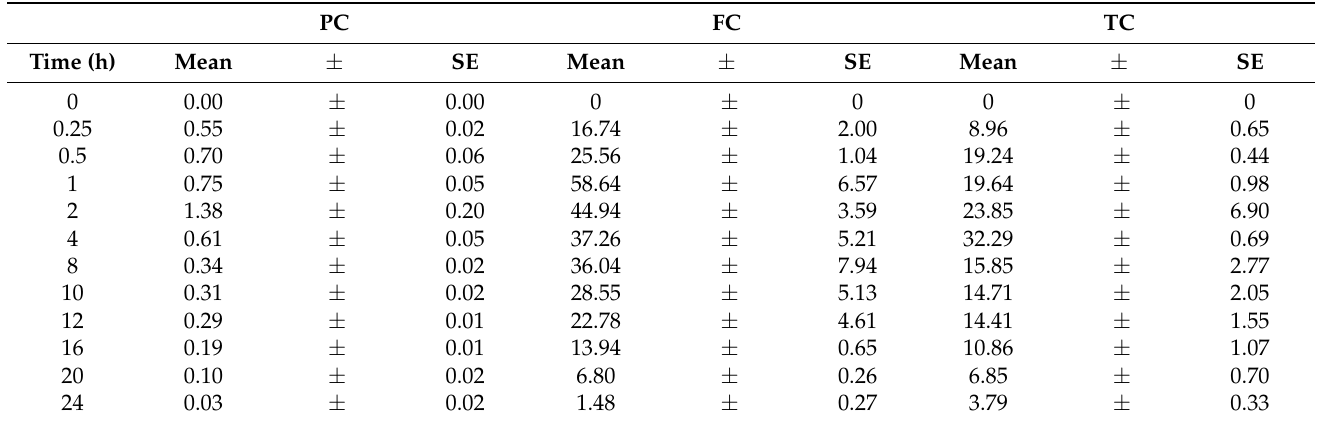
Table 5. Measurement and calculation of TAA conc. ( µ g/mL) in plasma, PC; fluid of lung, FC; and tissue of lung after insufflation, TC. Mean ± SE, n =